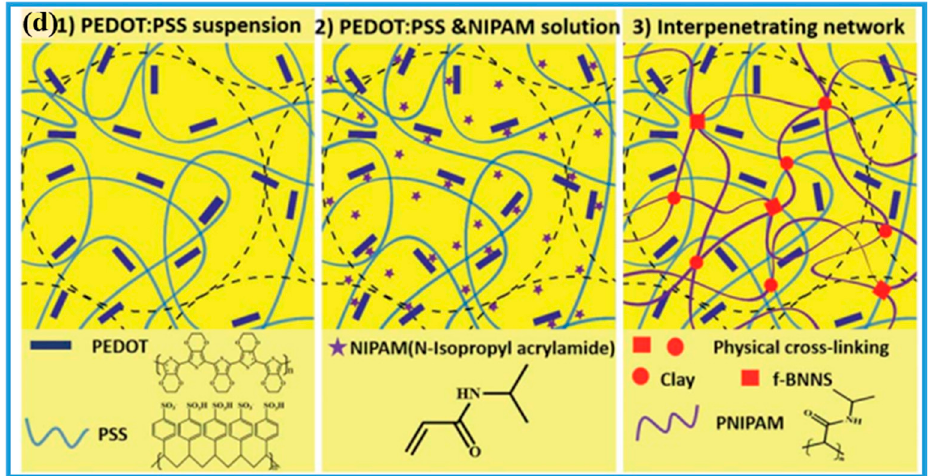
Figure 9. ( a ) Illustration of preparation process of quaternized chitosan. ( b ) Illustration of preparation process of rGO-PDA. ( c ) Illustration of preparation process of PNIPAM-ECH with quaternized chitosan and rGO-PDA served as conductive components. Copyright from Ref. [89] ACS publications. ( d ) Illustration of preparation process with PEDOT:PSS and clay served as conductive components. Copyright from Ref. [73] Royal Society of Chemistry.